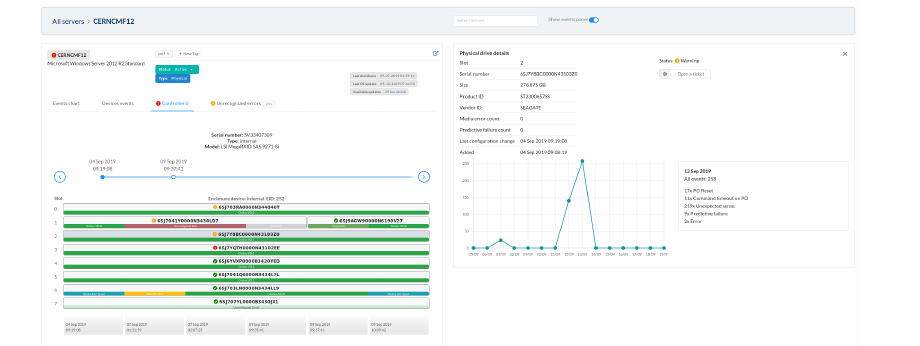
Figure 4. Server configuration history and physical drive details.